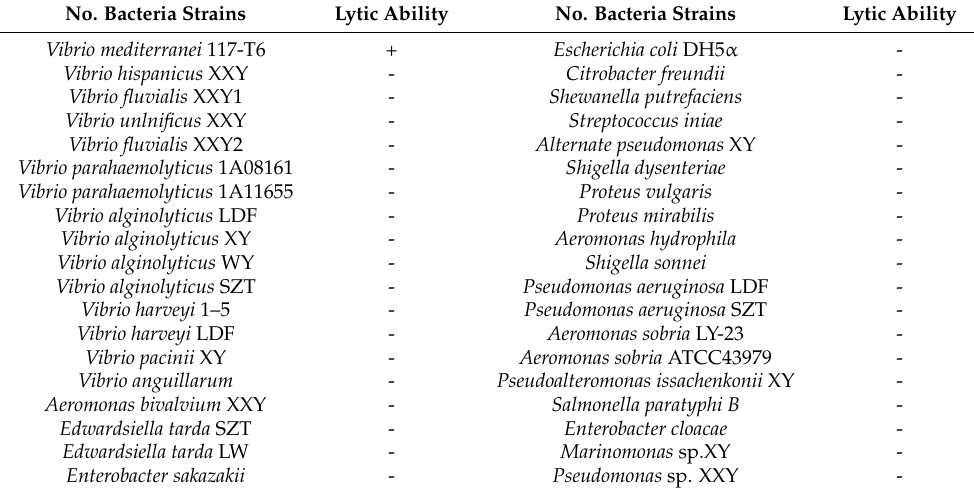
Table 1. Bacterial strains used in the host range assay and infection